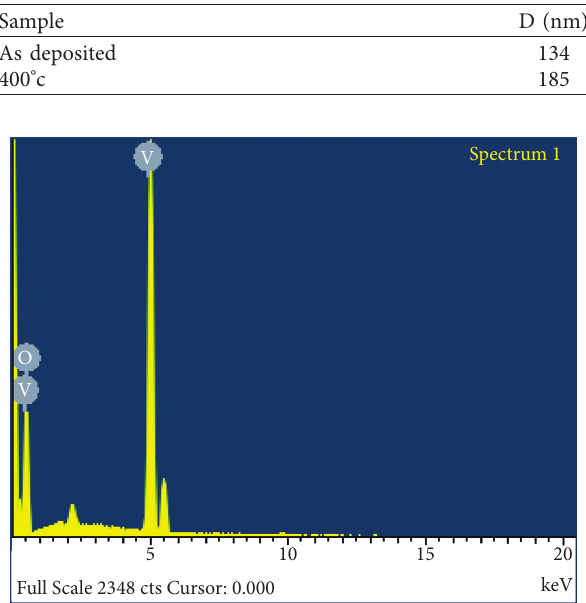
Figure 3: V 2 O 5 EDAX spectra.